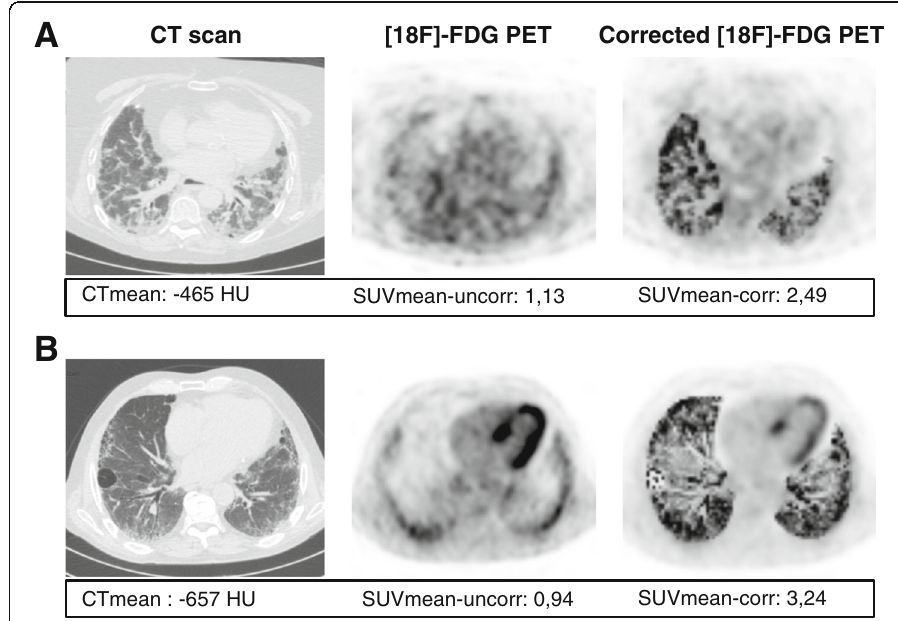
Fig. 1 Representative CT, uncorrected and corrected [18F]-FDG PET images. The value of the correction for the tissue fraction is illustrated by representative CT and [18F]-FDG PET images obtained in two patients ( a and b ). Interstitial abnormalities were significantly more pronounced in patient a than in patient b , as shown on CT images (left panels). The corresponding uncorrected PET images (middle panels) showed, in patient a , an increased [18F]-FDG uptake in the dense areas of the lung. This increase probably resulted, at